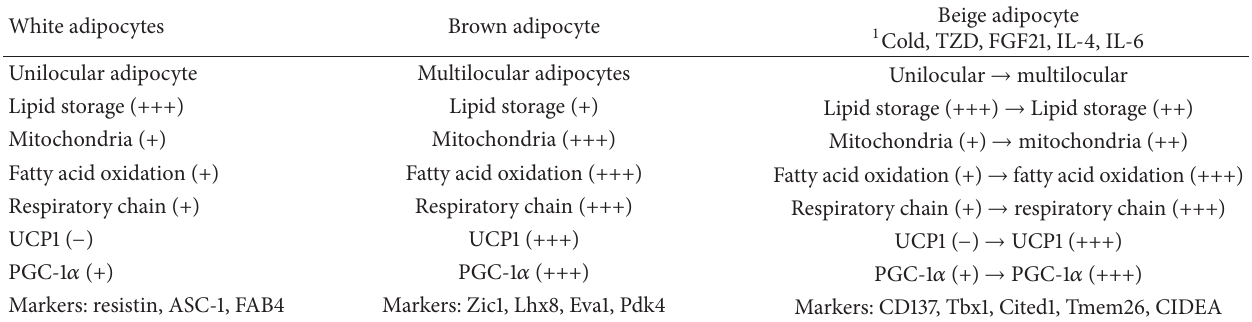
Table 1: Characteristic of different kind of adipocyte